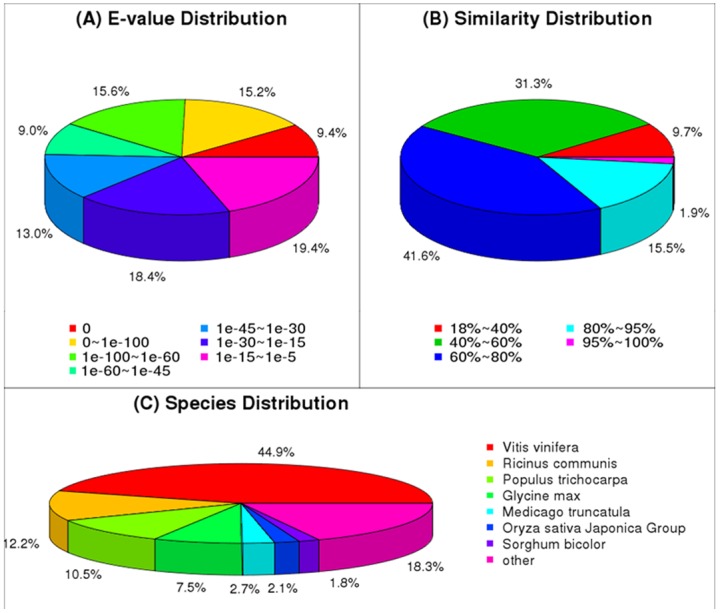
Characteristics of homology search of Illumina sequences against the nr database.(A) E-value distribution of BLAST hits for each unique sequence with a cut-off E-value of 1.0E-5. (B) Similarity distribution of the top BLAST hits for each sequence. (C) Species distribution is shown as a percentage of the total homologous sequences with an E-value of at least 1.0E-5.